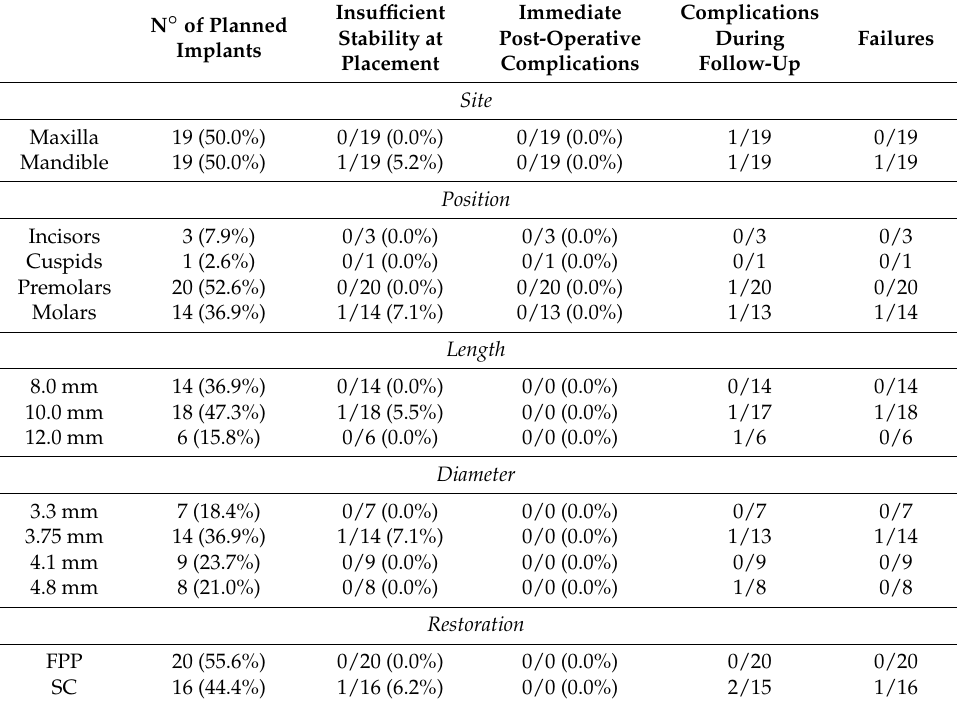
Table 1. Distribution of the implants with related failures for stability and complications.